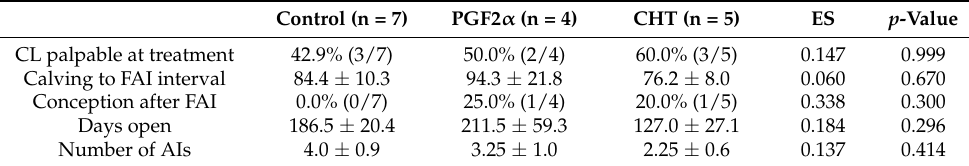
Table 2. Reproductive performance and percentage of cows in all three groups.